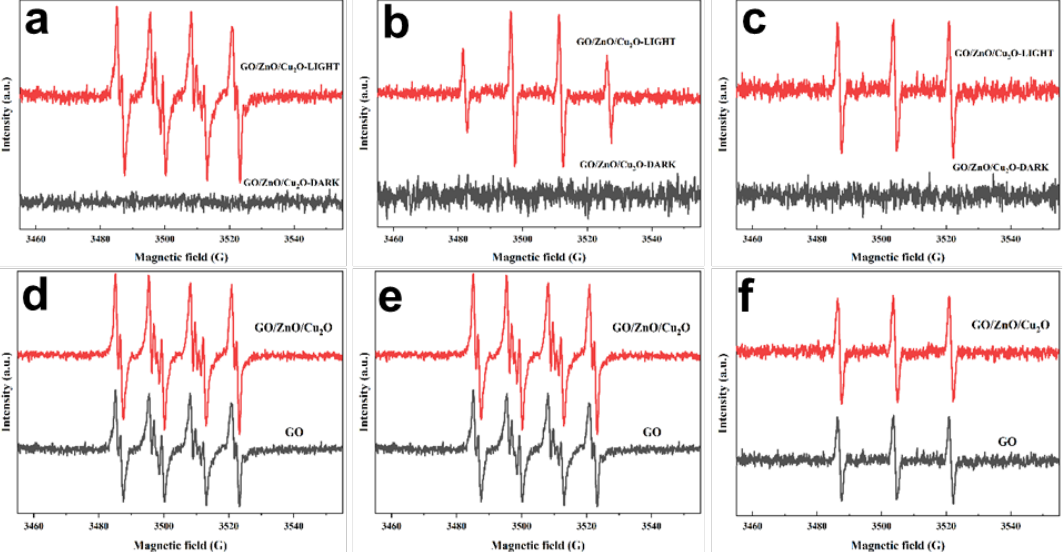
Figure 7. GZC antibacterial powder and GZC antibacterial powder and GO ESR spectra of three oxygen radicals produced under light and dark conditions. ( a,d ) [DMPO-O 2 − ] addition product. ( b,e ) [DMPO-OH] · addition product. ( c,f ) TEMPO.